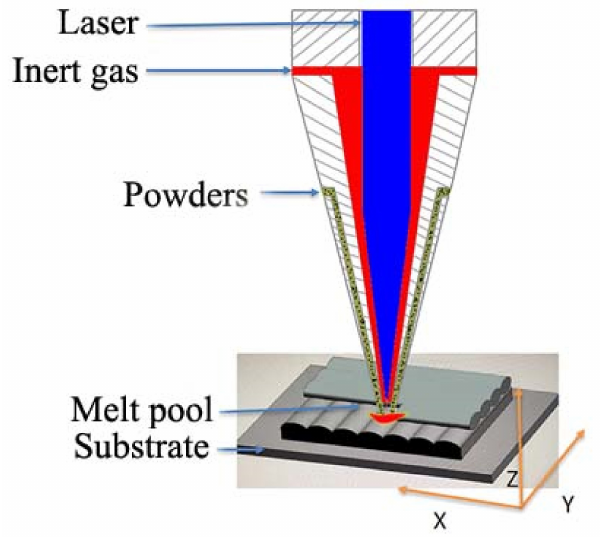
Figure 1. Basic structure diagram of